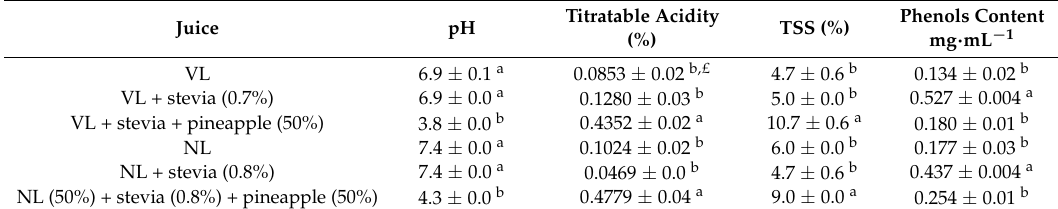
Table 6. Quality variables of chayote juice of virens levis (VL) and nigrum spinosum (NS) and its combination with stevia and pineapple